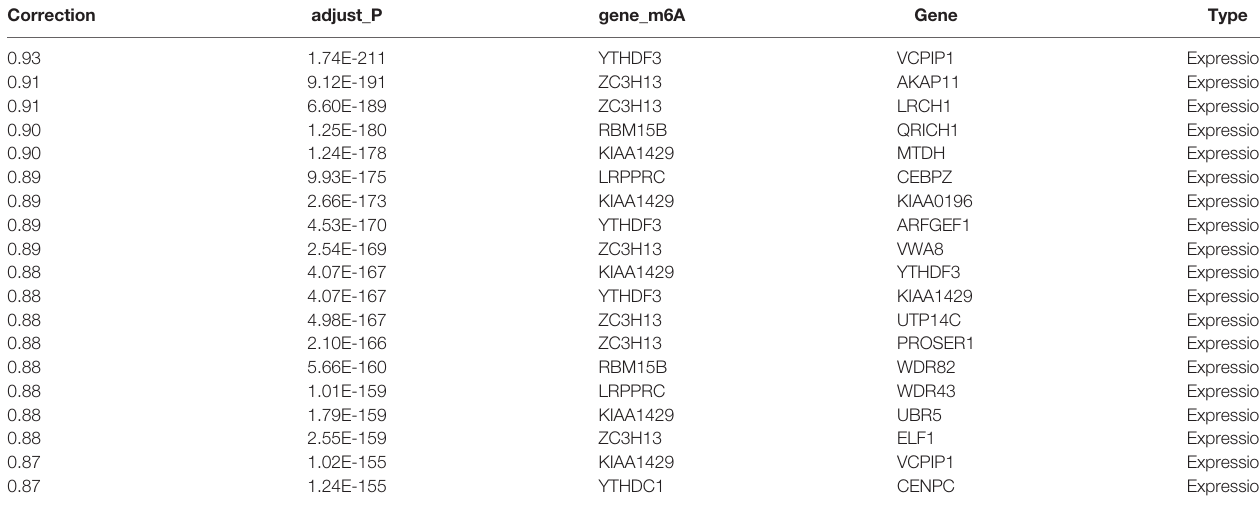
TABLE 4 | Genes were signi fi cantly correlated with m6A regulators at the transcription level (top 20). Correction